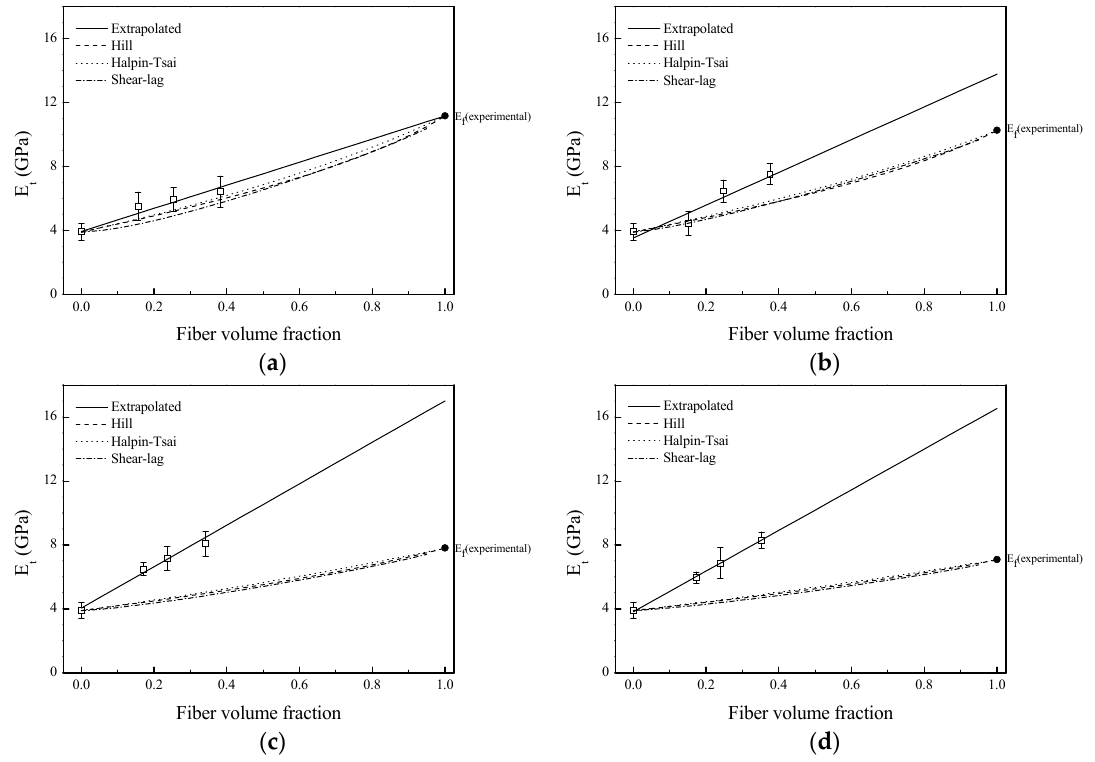
Figure 5. Estimation of composite modulus values using fiber experimental Young modulus values: ( a ) untreated; ( b ) silane; ( c ) NaOH; and ( d ) NaOH + silane.